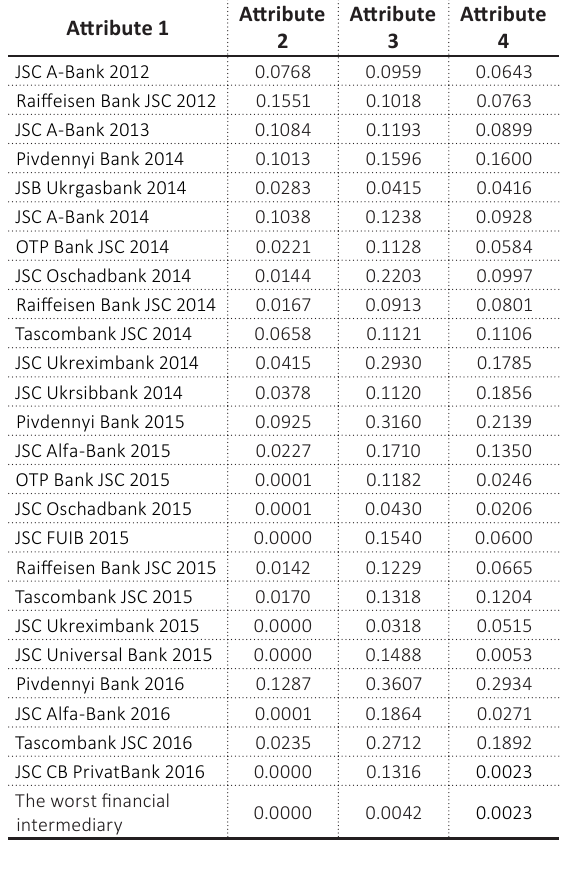
Table 15. Financial intermediaries of the newly formed pattern